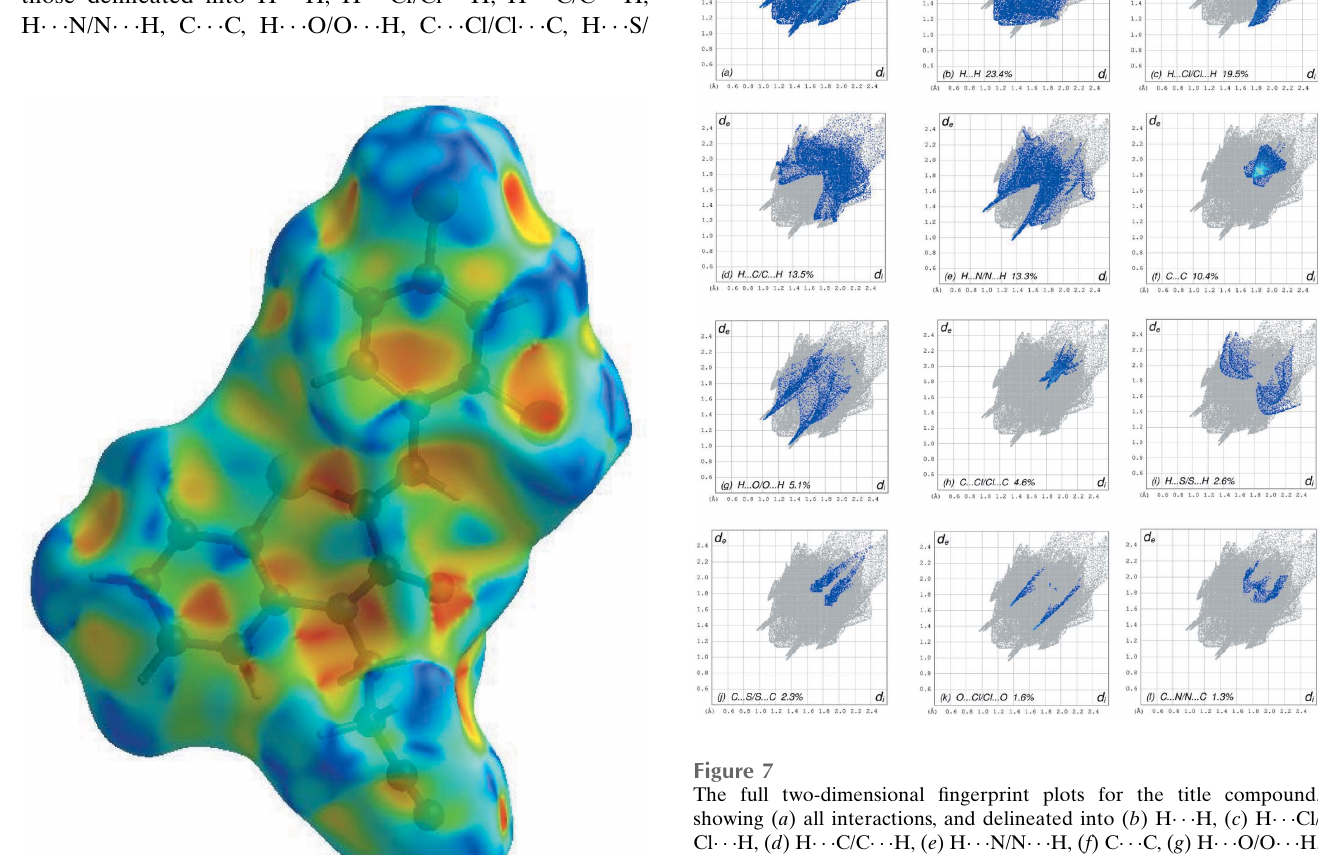
Figure 7 The full two-dimensional fingerprint plots for the title compound, showing ( a ) all interactions, and delineated into ( b ) H (cid:2)(cid:2)(cid:2) H, ( c ) H (cid:2)(cid:2)(cid:2) Cl/ Cl (cid:2)(cid:2)(cid:2) H, ( d ) H (cid:2)(cid:2)(cid:2) C/C (cid:2)(cid:2)(cid:2) H, ( e ) H (cid:2)(cid:2)(cid:2) N/N (cid:2)(cid:2)(cid:2) H, ( f ) C (cid:2)(cid:2)(cid:2) C, ( g ) H (cid:2)(cid:2)(cid:2) O/O (cid:2)(cid:2)(cid:2) H, ( h ) C (cid:2)(cid:2)(cid:2) Cl/Cl (cid:2)(cid:2)(cid:2) C, (i) H (cid:2)(cid:2)(cid:2) S/S (cid:2)(cid:2)(cid:2) H, ( j ) C (cid:2)(cid:2)(cid:2) S/S (cid:2)(cid:2)(cid:2) C, ( k ) O (cid:2)(cid:2)(cid:2) Cl/Cl (cid:2)(cid:2)(cid:2) O and ( l ) C (cid:2)(cid:2)(cid:2) N/N (cid:2)(cid:2)(cid:2) C interactions. The d i and d e values are the closest internal and external distances (in A˚ ) from given points on the Hirshfeld surface